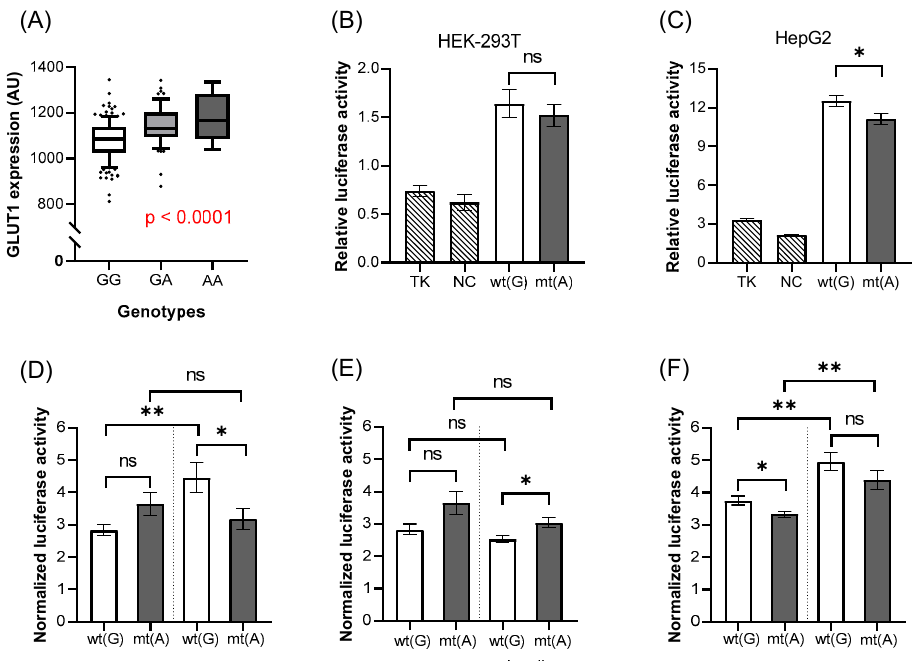
Figure 4. The effects of rs841848 on GLUT1 expression and luciferase activity. The association between the expression of the GLUT1 membrane protein and the genotypes of the variant ( A ). Each boxplot represents samples with different genotypes, in the range of 10–90 percentile, while dots represent samples out of range. This insert has increased luciferase activity in HEK-293T ( B ) and HepG2 ( C – F ) cells, compared to the empty vector but the mutant allele decreases this enhancer effect in HepG2 cells ( C ). In FBS-free medium ( D , E ), the opposite result could be seen. Wild-type allele has a stimulating effect on luciferase expression under low concentrations of glucose. Hypoxia increased luciferase expression, regardless of the alleles. The p -values of the luciferase experiments ( B – F ) were calculated using the Welch t -test. The stars represent significance at different levels: * p < 0.05, ** p < 0.01. In the case of the treatments, data were normalized to the results of the “empty” vector. Stars representing the strength of the significance; wt(G): wild-type allele; mt(A): mutant allele; TK: “empty” vector without insert; NC: negative control (random sequence); ns: not significant; AU: arbitrary